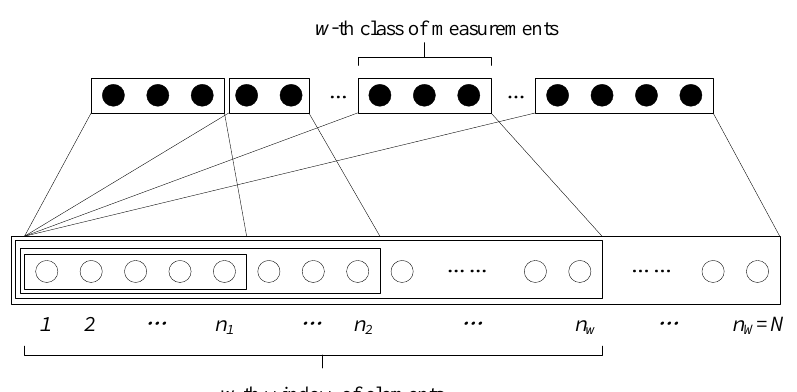
Figure 2. Expanding window compressed